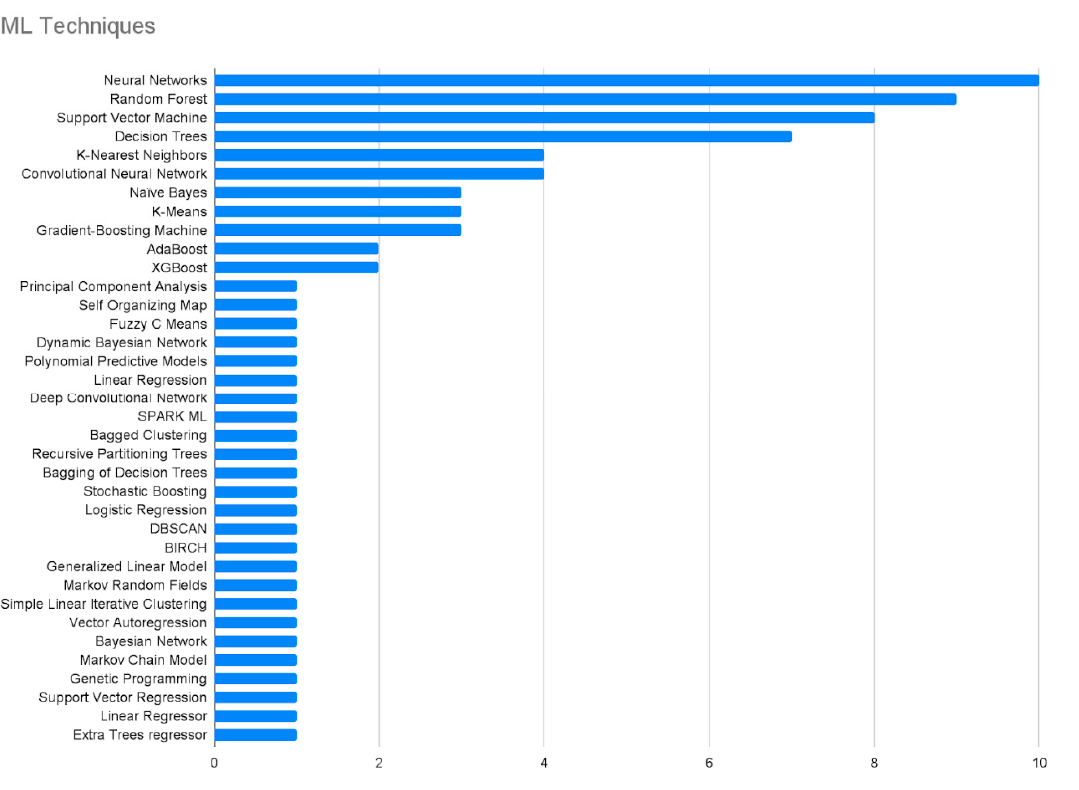
Figure 12. ML techniques used in agricultural Big